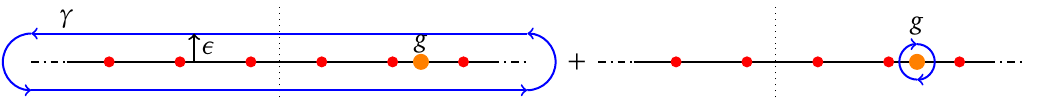
Figure 4: Contour γ from (39). It may be taken counter-clockwise, a distance ε around the whole real line. However, to compensate for picking up the pole at = g ∈ 2 π (cid:90) , we add the reverse contribution there. Red dots sym- k → g = g a b L π ( n − ν ) , n ∈ (cid:90) bolize poles k → 2 L